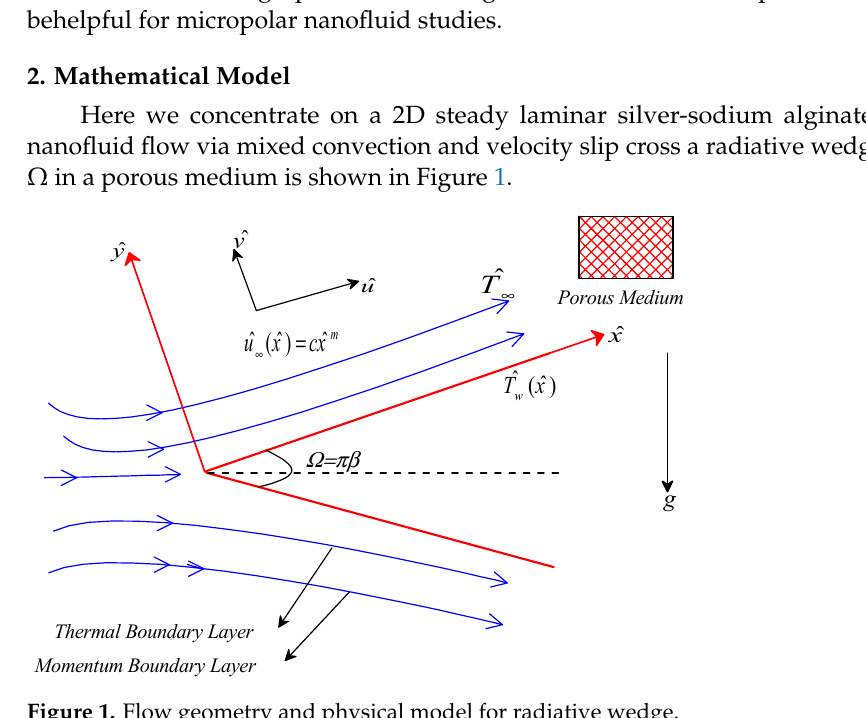
Figure 1. Flow geometry and physical model for radiative wedge.